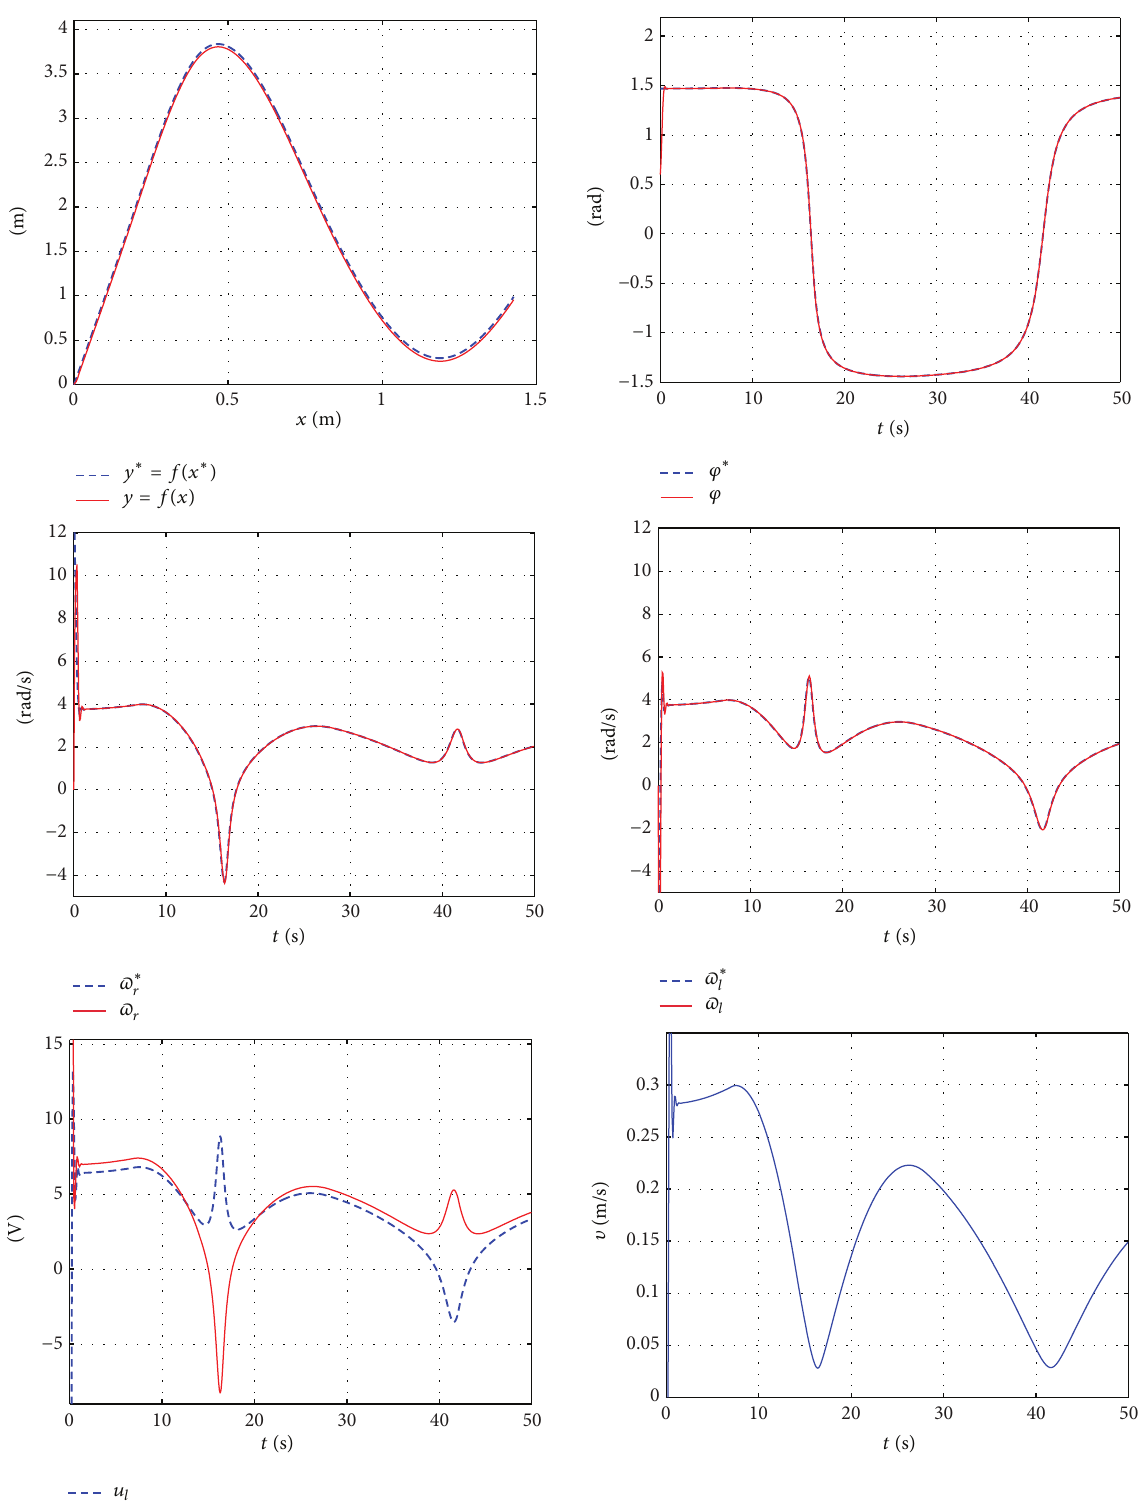
Figure 18: Simulation results for a curve obtained from given